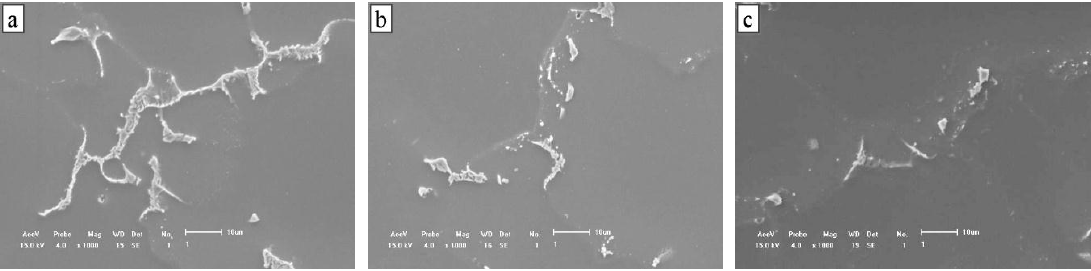
Figure 9. Scanning electronic microscope (SEM) images: ( a ) no ultrasonic treatment; ( b ) fixed-frequency ultrasonic treatment; ( c ) variable-frequency ultrasonic treatment.